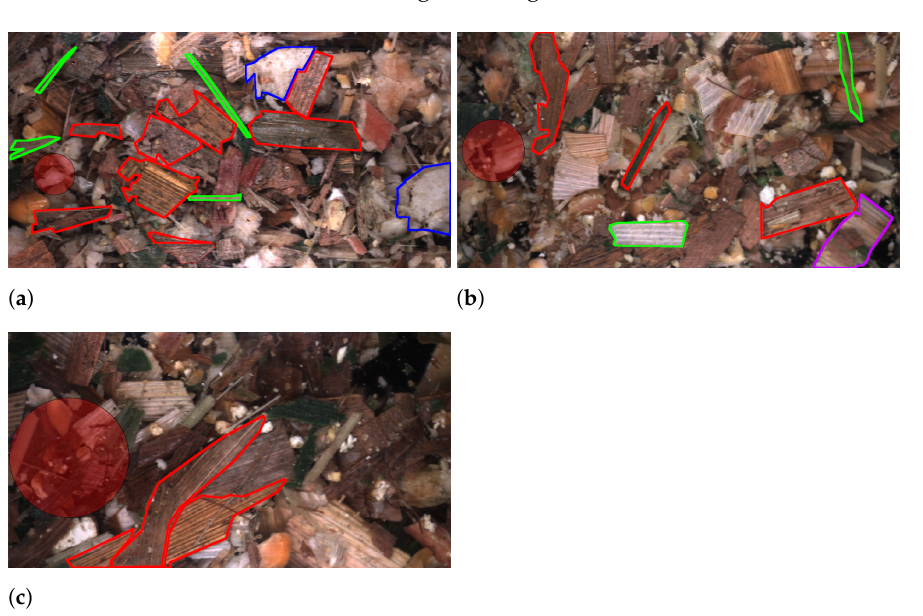
Figure 8. Differences in image content and annotations for three TLOC. In ( a ) samples are harvested with 4 mm, ( b ) with 6 mm, and ( c ) with 11.5 mm. For each image the overlength definition of 1.5 × TLOC is shown by diameter of the red